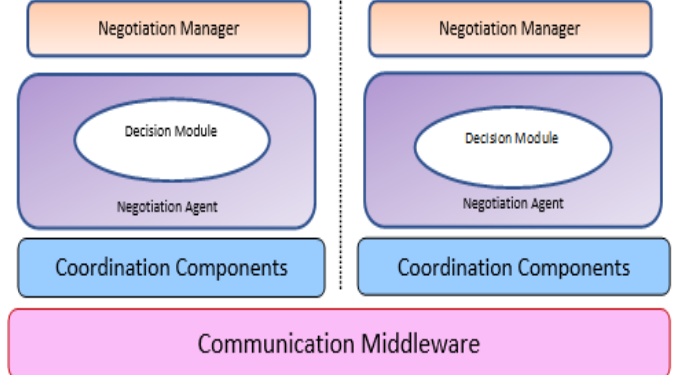
Figure 3. Negotiation architecture for each partner.